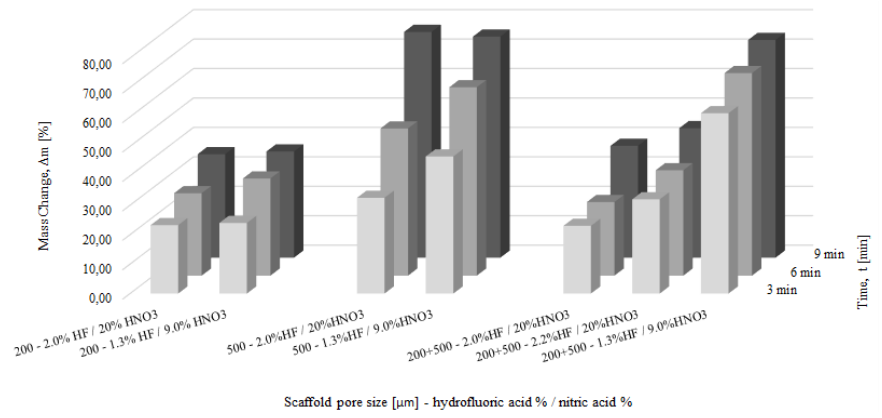
Figure 6. Mass change of scaffolds treated in hydrofluoric acid/ nitric acid baths for 3, 6 and 9 min.